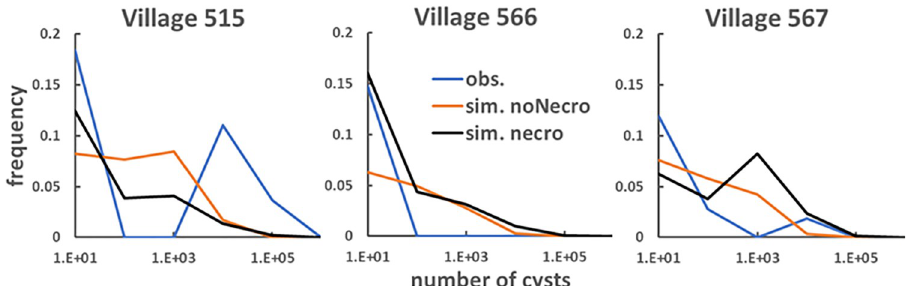
curves are the product of the average over 750 runs using the minimum ABC distance parameter sets for both the necro and noNecro setups.